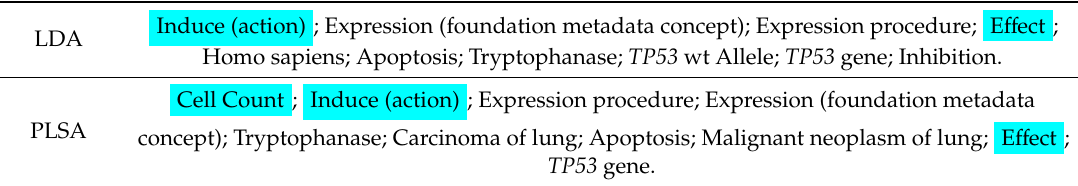
Table 8. The top-1 topic on the sustaining proliferative signaling (SPS) hallmark. Patients ; Epidermal Growth Factor Receptor Measurement; Epidermal Growth Factor LDA Receptor; EGFR protein, human; Combined; Therapeutic procedure; Tryptophanase; Non-Small Cell Lung Carcinoma; EGFR gene; combination of objects. Epidermal Growth Factor Receptor Measurement; EGFR protein, human; Epidermal Growth Factor Receptor; EGFR gene; Non-Small Cell Lung Carcinoma; Patients ; Tryptophanase; PLSA Therapeutic procedure; Non-Small Cell Lung Cancer Pathway; NCI CTEP SDC Non-Small Cell Lung Cancer Sub-Category Terminology. Table 9. The top-1 topic on the evading growth suppressor (EGS) hallmark.